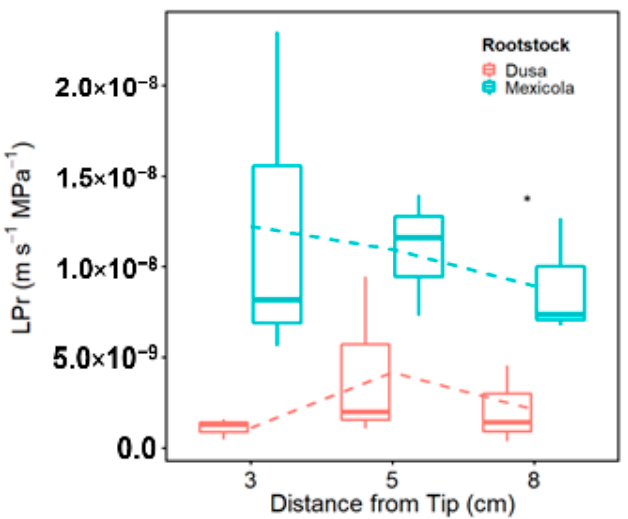
Figure 1. Fine root hydraulic conductivity ( LP r ) at different distances from the root tip (3, 5 and 8 cm) and in two rootstocks ( “M exicola ” and “ Dusa ” ). * Stands for significant differences ( p > 0.05) of a two-way ANOVA test followed by a Tukey HSD.